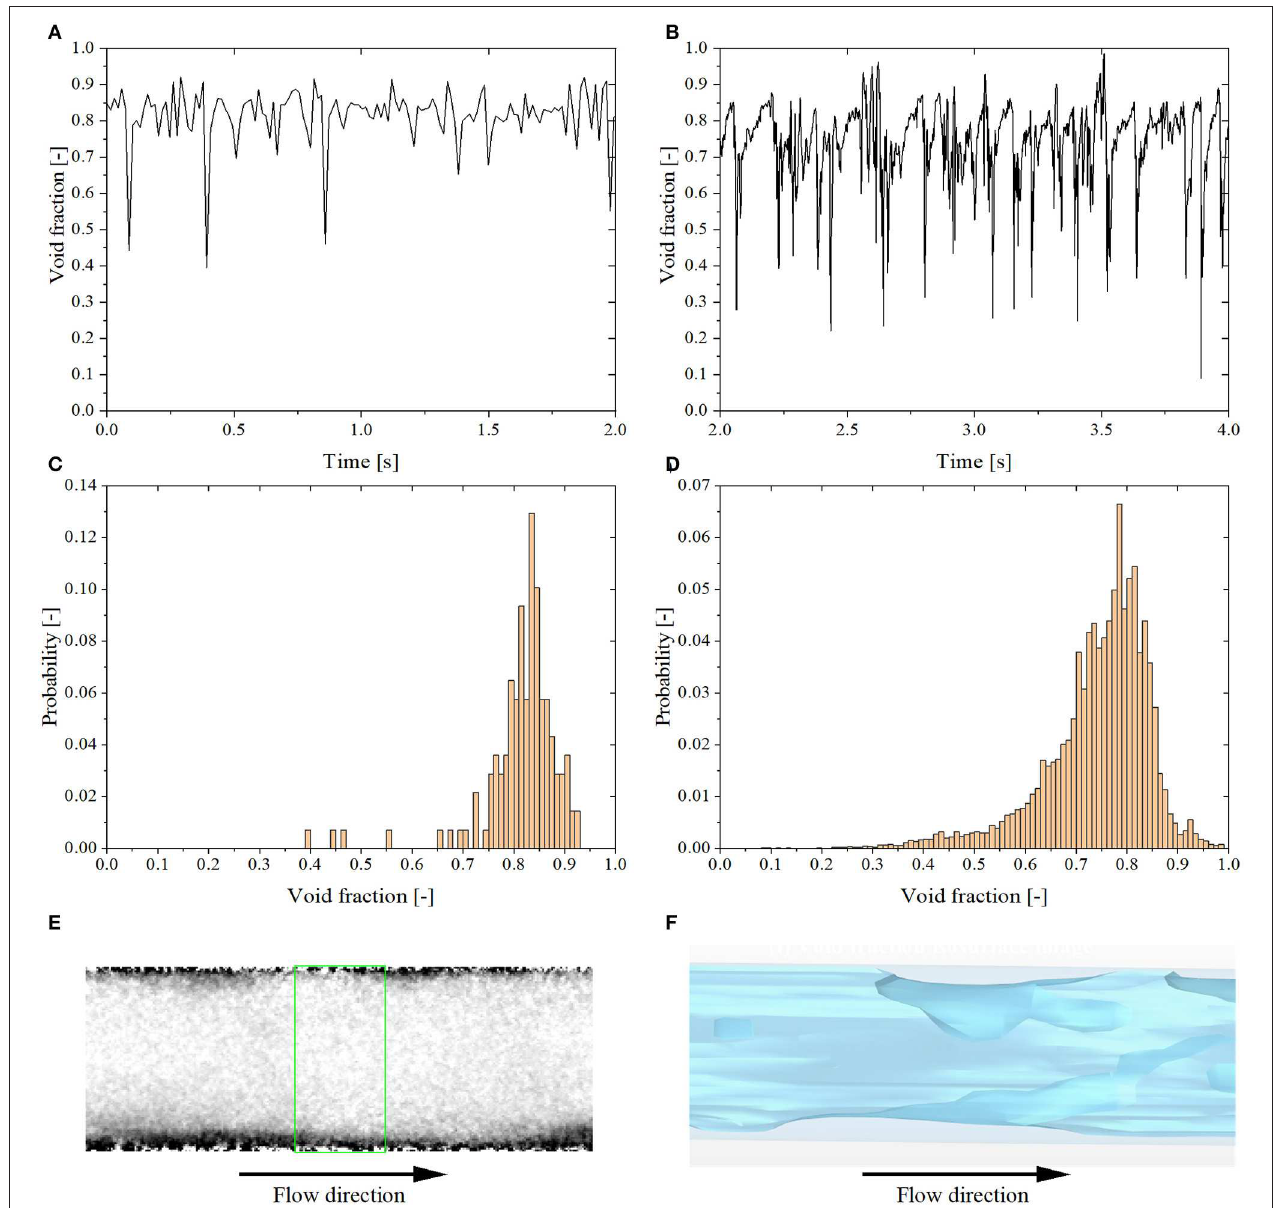
FIGURE 10 | Results of test No. 9. (A) Experimental void fraction time evolution. (B) Simulation void fraction time evolution. (C) Experimental void fraction histogram. (D) Simulation void fraction histogram. (E) X-ray void fraction contrast image. (F) Void fraction isosurface